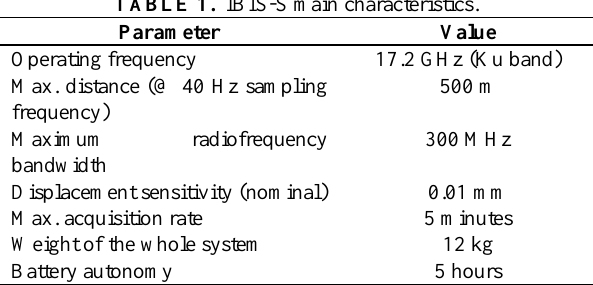
Figure 1. Example of a GB-SAR image (one pixel corresponds to azimuth and range radar sampling of the observed area) and a RAR 1D image of the same area